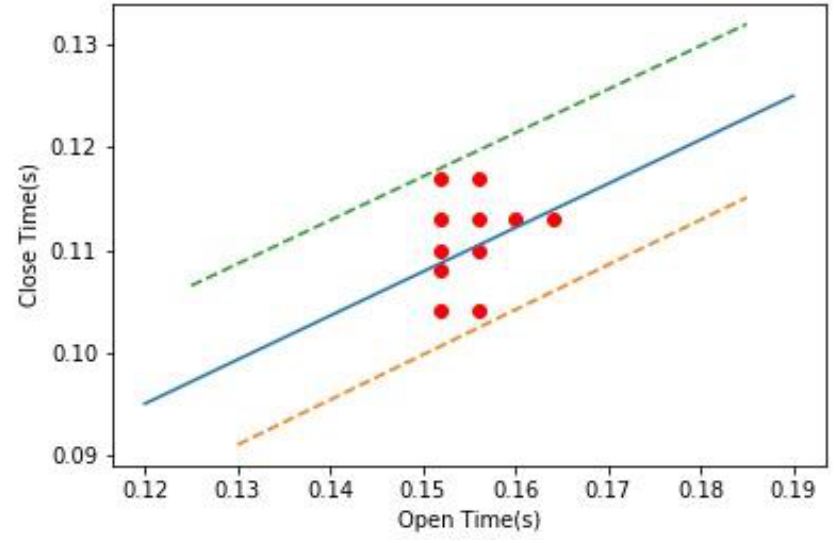
Figure 12. Linear regression model.